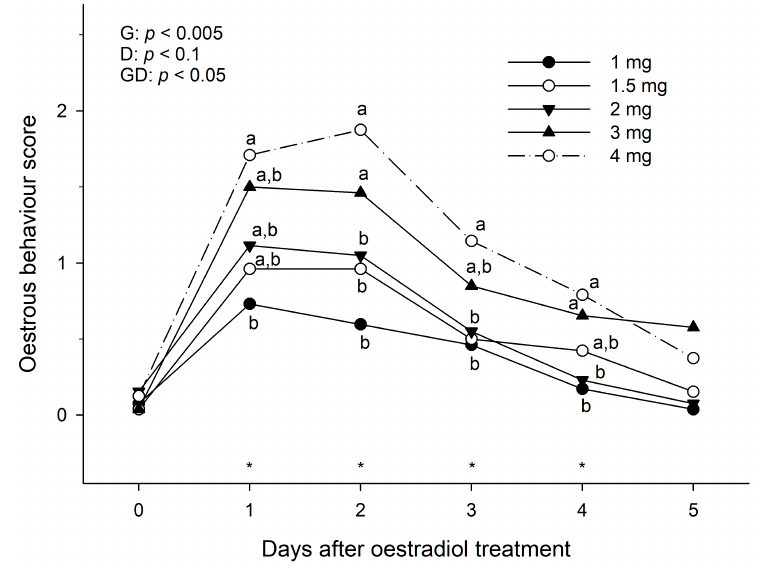
Figure 3. Mean oestrous behaviour score in anoestrous mares treated with different dose rates of oestradiol benzoate in a single administration (Day 0). Probabilities for main effects of dose group (G), Day (D), and the group-by-day interaction (GD) are shown. Within a given Day (*), different letters (a, b) indicate a significant difference ( p < 0.05) in oestrous behaviour score between dose groups.